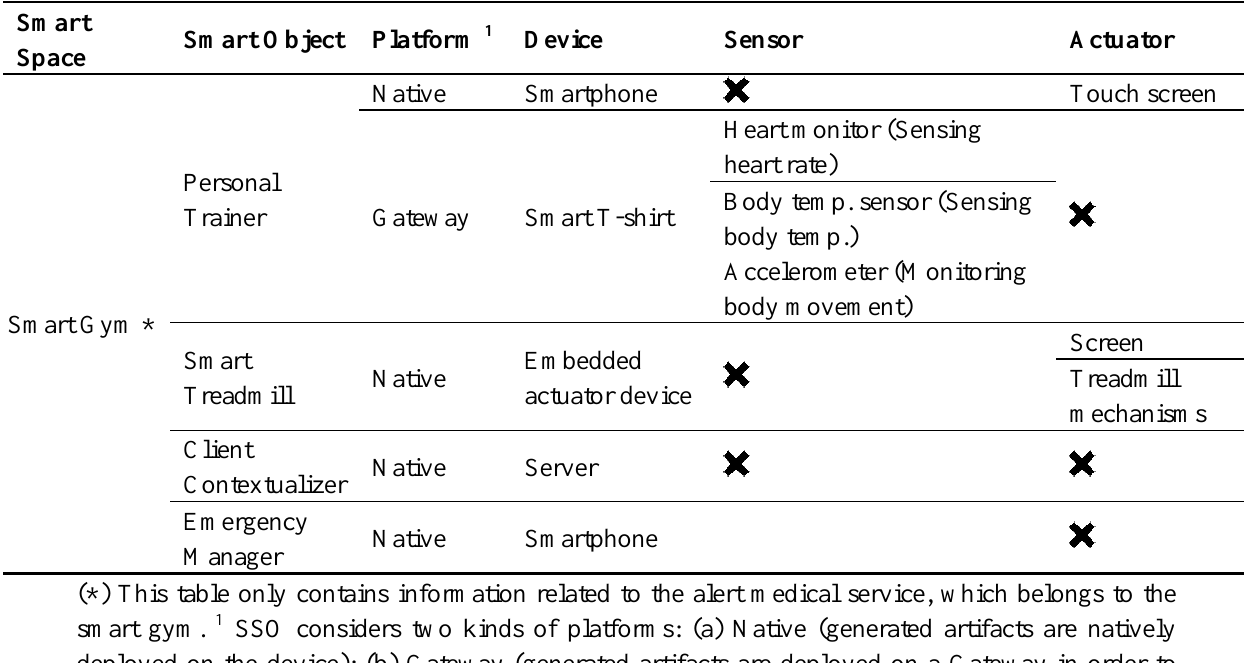
Table 7. Report of the analysis of domain aspects in the smart gym.